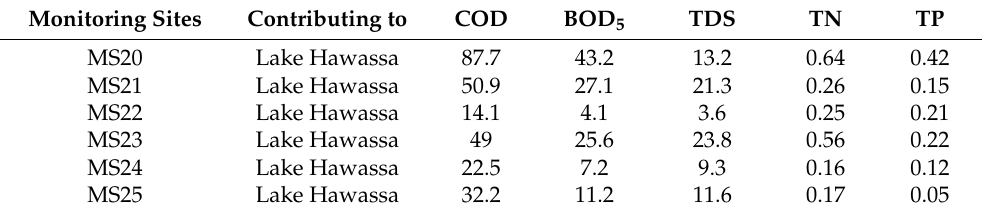
Table 12. Stormwater pollutant loads of selected physicochemical parameters in Hawassa City, t/y. Monitoring Sites Contributing